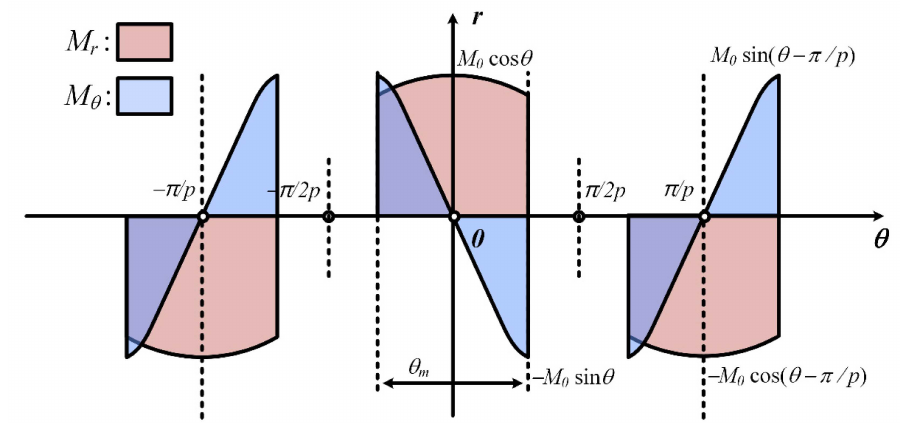
Figure 2. Two-dimensional FE analysis